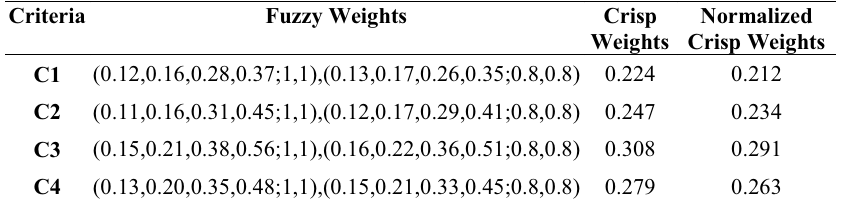
Table 8: Fuzzy and Normalized weights of the criteria Criteria Fuzzy Weights Crisp